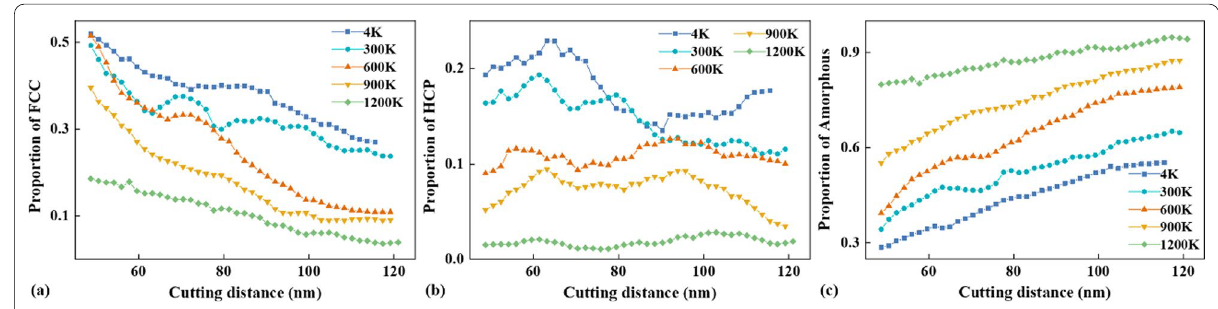
Fig. 9 The proportions of atomic types plotted with cutting distance for different temperature, a FCC, b HCP, c